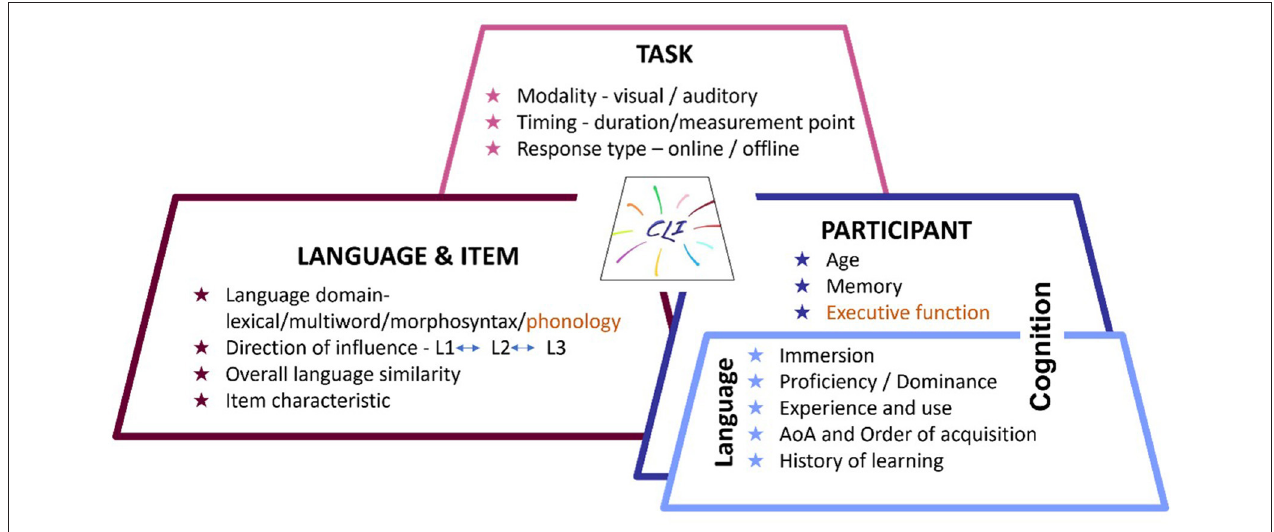
FIGURE 1 | Modulators of CLI. Figure presents modulators of CLI identified in the current volume grouped by category. In orange, we also include modulators not represented in the current volume but which we believe might be important for future